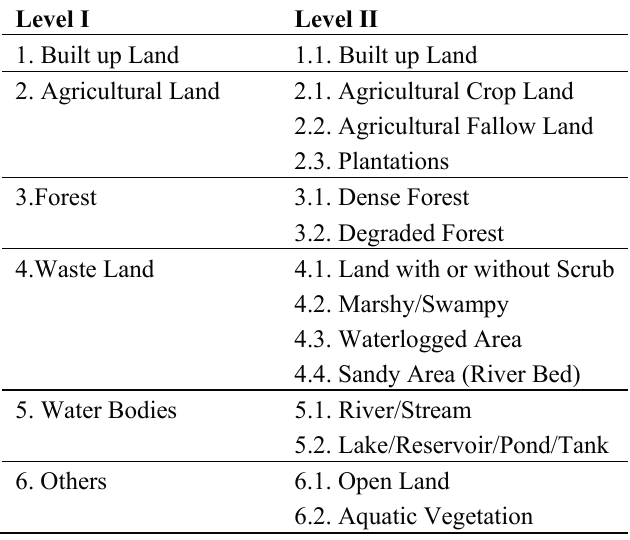
Table 3. Levels and LULC classes considered for